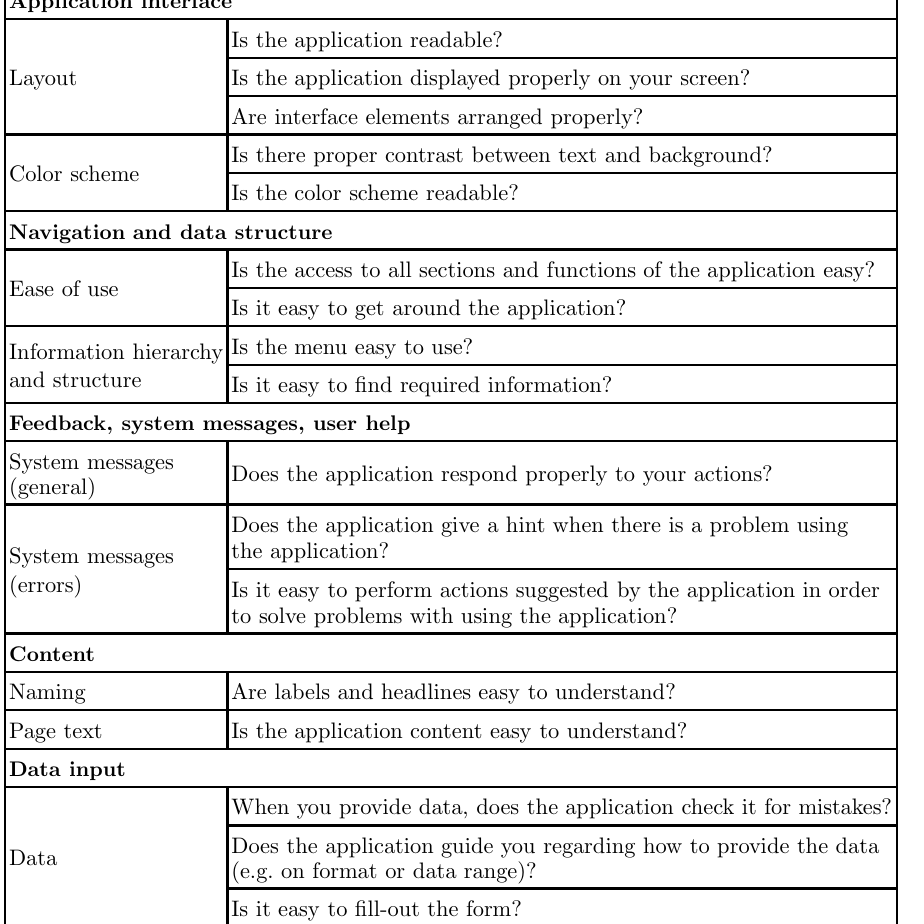
Table 1. The list of predefined testing areas with questions assigned Application